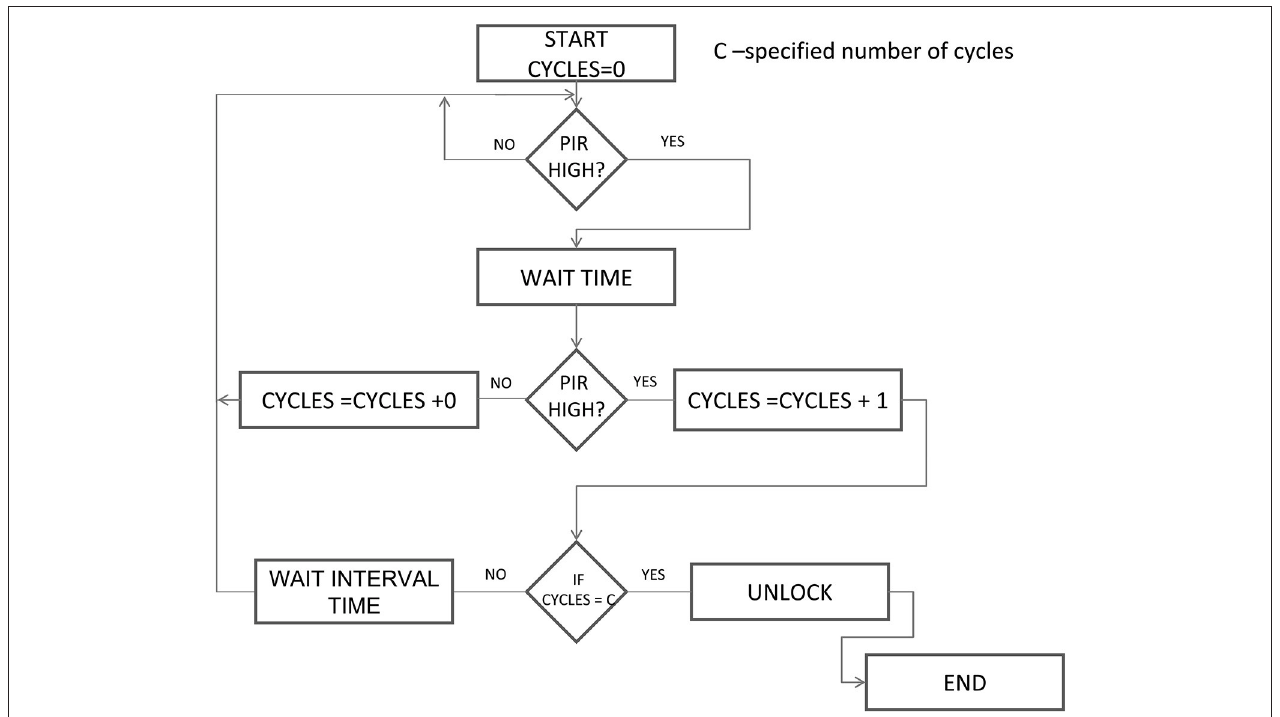
FIGURE 2 | Block diagram showing the operation of the